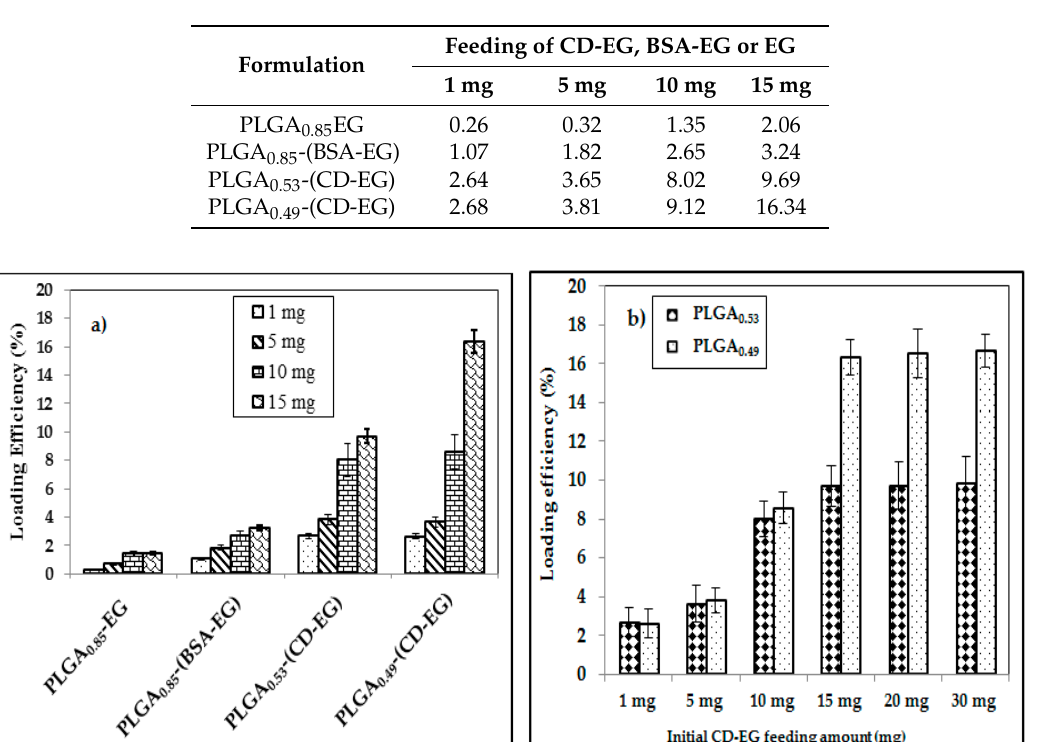
Table 3. Drug loading efficiency (%) of various PLGA copolymers with different feedings of CD-EG, BSA-EG, or EG.